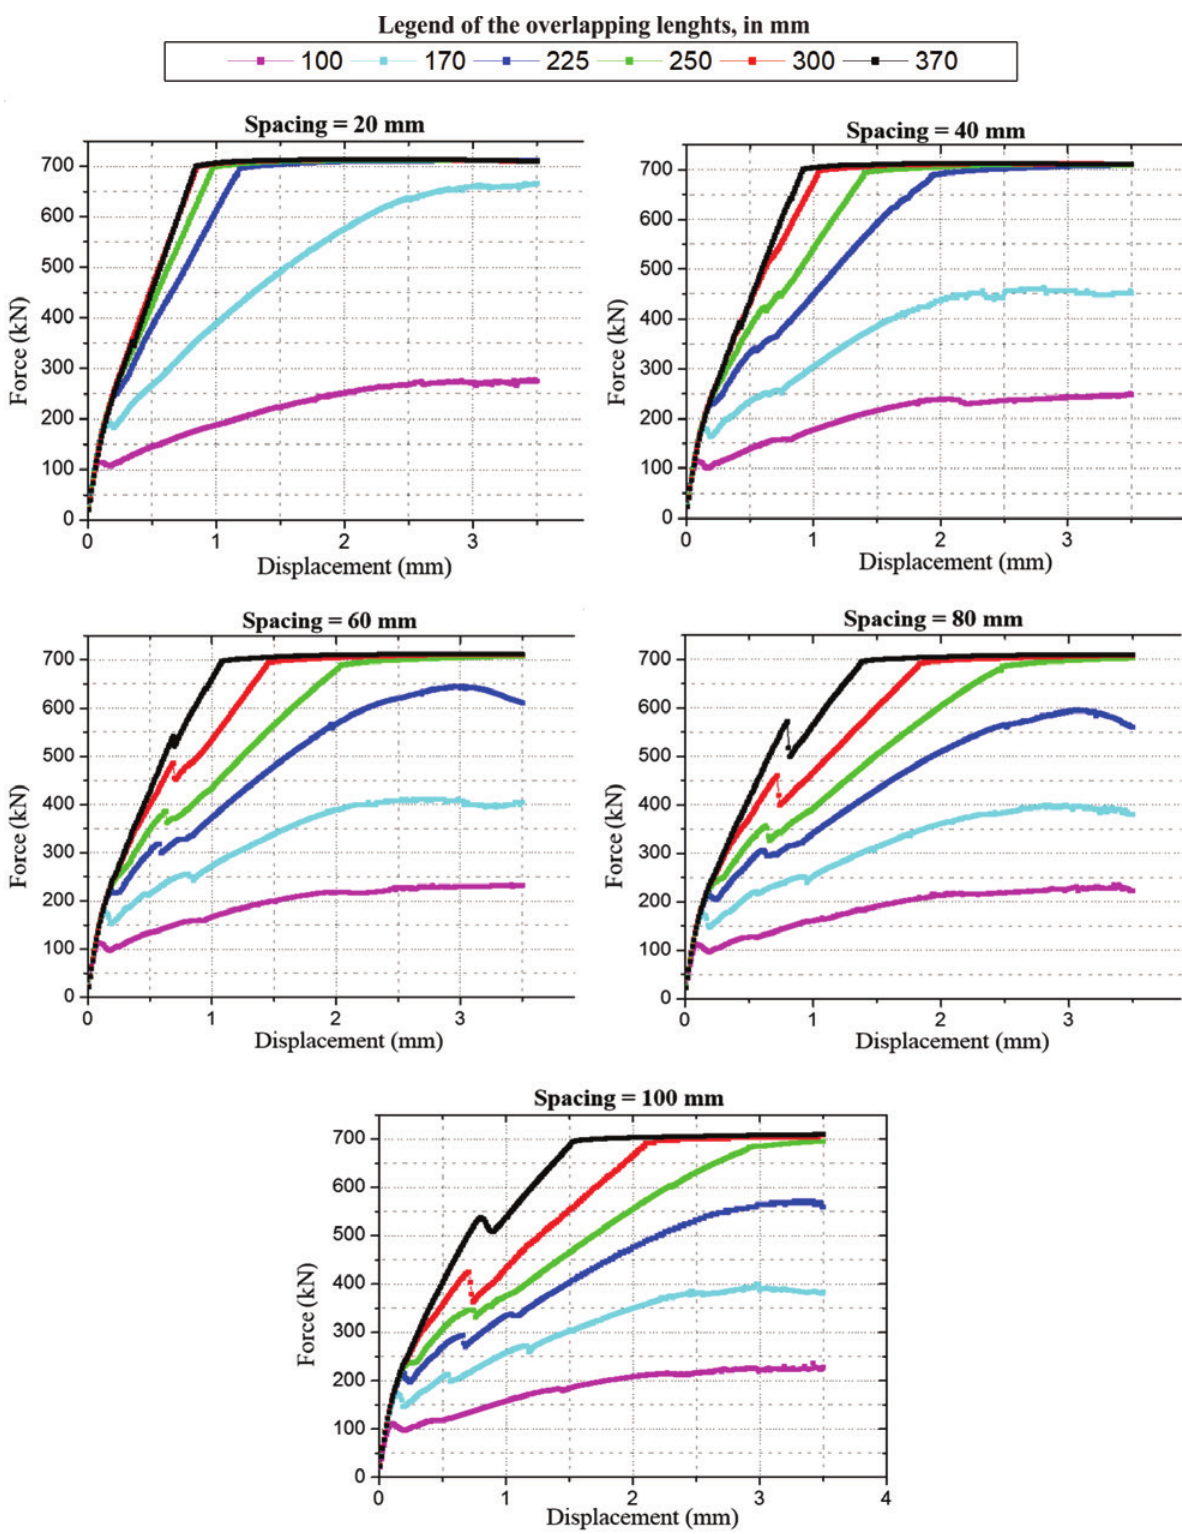
Figure 13 Graphics of the joints with constant